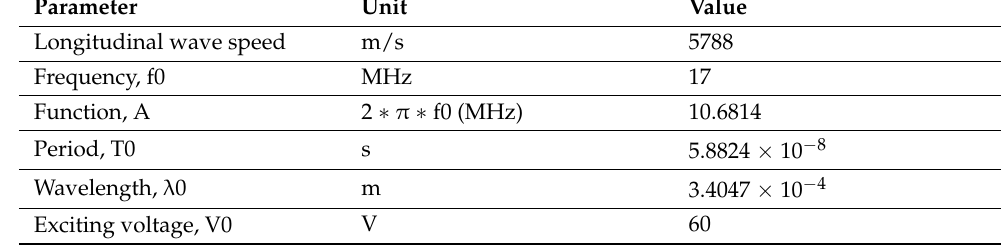
Table 1. Input parameters of acoustoelasticity model for smart bolt.